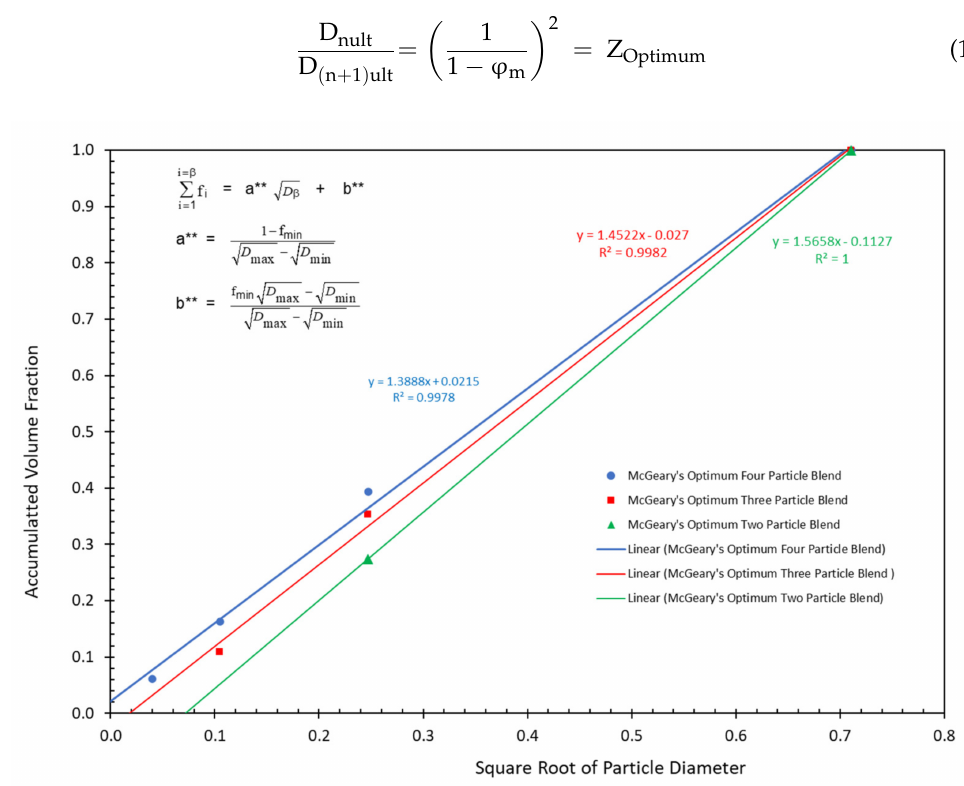
Figure 4. McGeary’s particle blend data vs. square root of particle diameter.